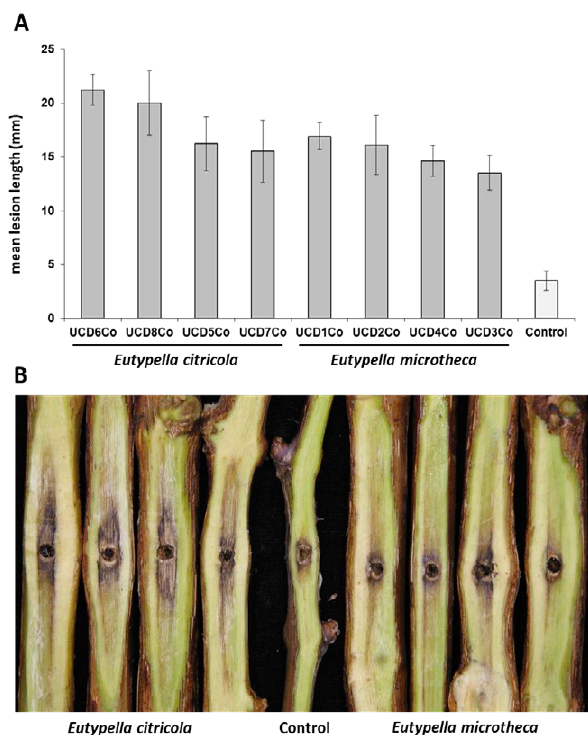
Figure 6. Pathogenicity test on cv. Red Globe grapevine plants inoculated with Eutypella citricola and E. microtheca isolates from vineyard spore traps. A. Mean lesion lengths caused by E. citricola and E. microtheca 5 months after inoculation. B. Vascular necrosis caused by E. citricola and E. microtheca in cv. Red Globe dormant canes compared to non-inoculated